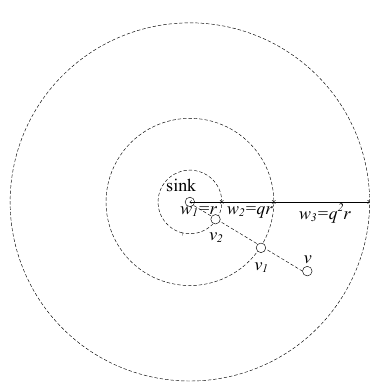
Figure 4 . Zoning in geometric progression.